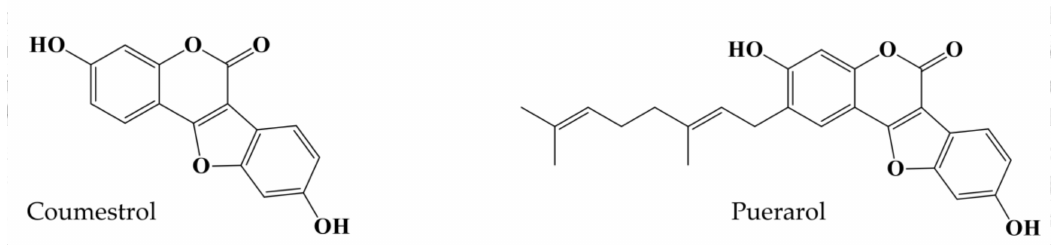
Figure 1. Structure of coumestrol and puerarol.